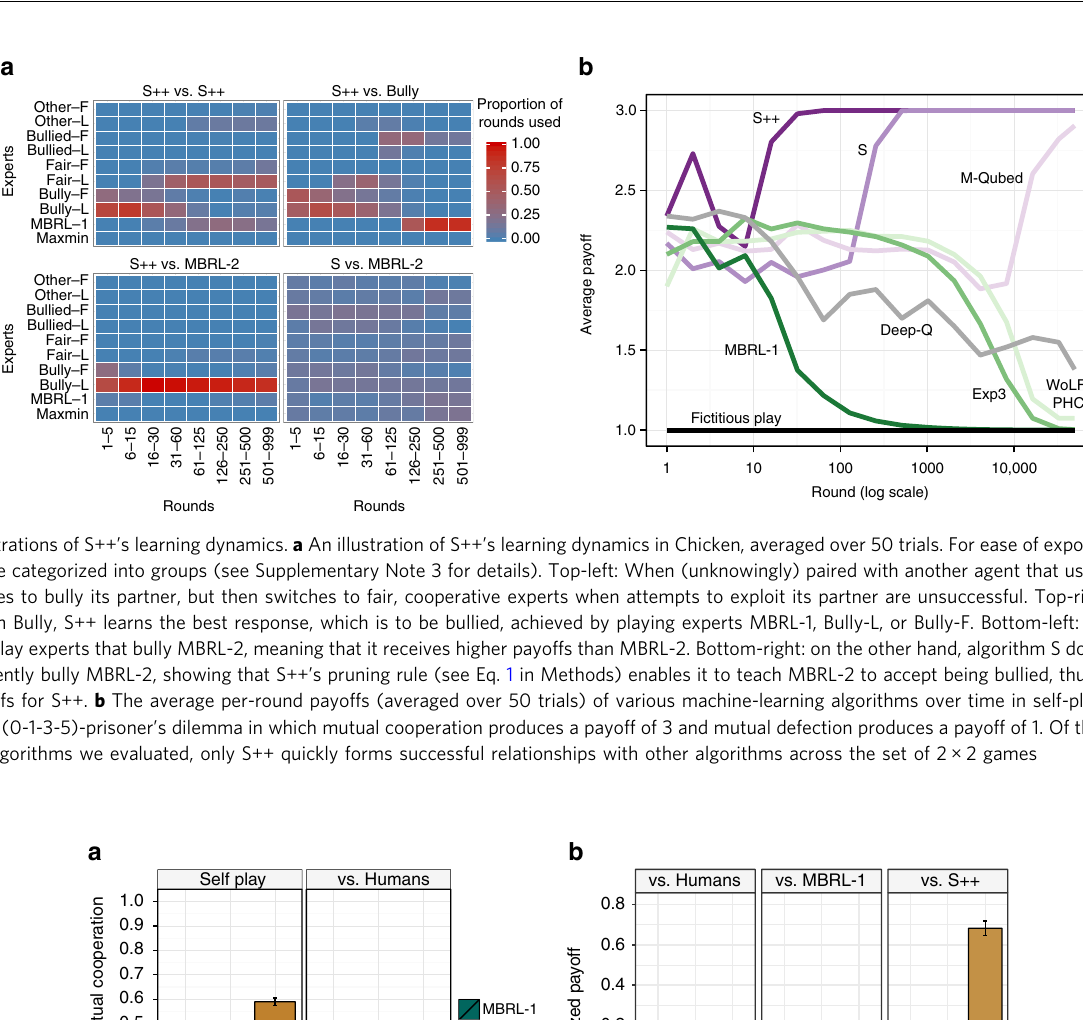
Fig. 4. When cheap talk was not permitted, human – human and human – S# pairings did not frequently result in cooperative relationships. However, across all three games, the presence of cheap talk doubled the proportion of mutual cooperation experienced by these two pairings. Thus, like people, S# used cheap talk to greatly enhance its ability to forge cooperative relationships with humans. Furthermore, while S# ’ s speech pro fi le was distinct from that of humans (Fig. 5a), subjective post- interaction assessments indicate that S# used cheap talk to promote cooperation as effectively as people (Fig. 5b). In fact,